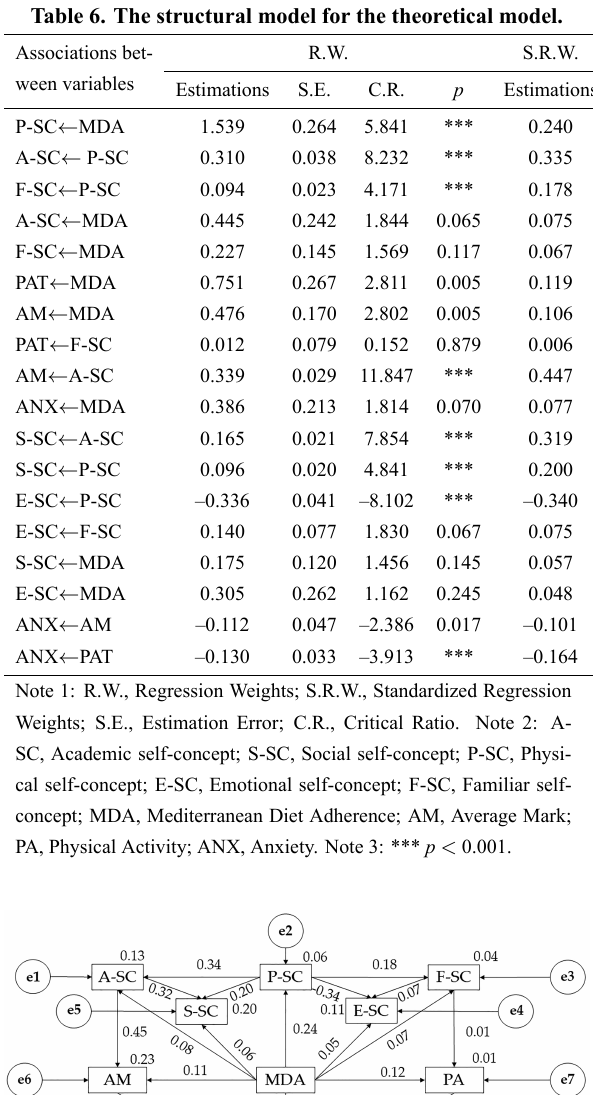
Mark; PA, Physical Activity; ANX, Anxiety. plays a key role in the adherence to the Mediterranean diet, with Spanish university students showing better adherence to the Mediterranean dietary pattern than other European undergraduates